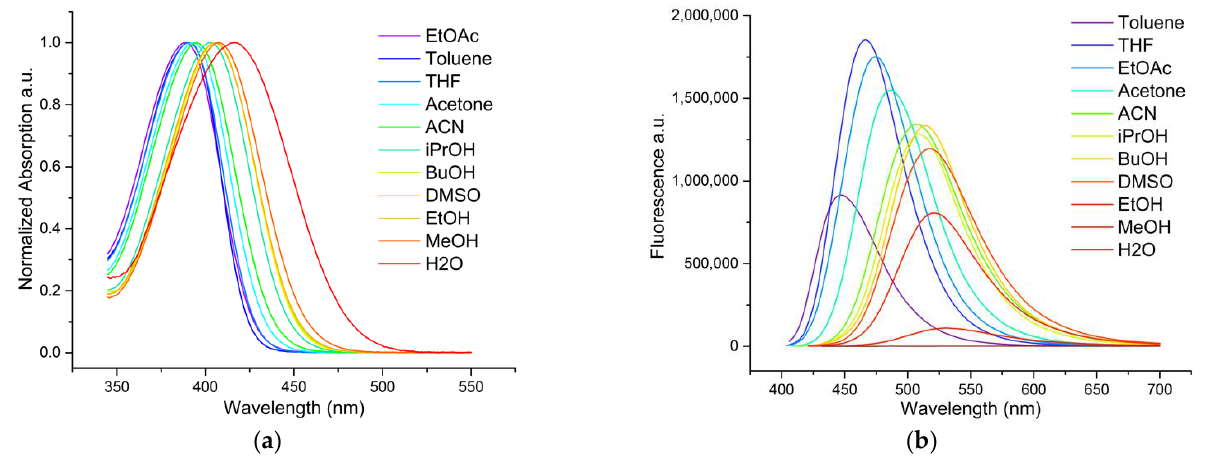
Figure 2. Absorption ( a ) and fluorescence ( b ) spectra of AlMF-Nu .